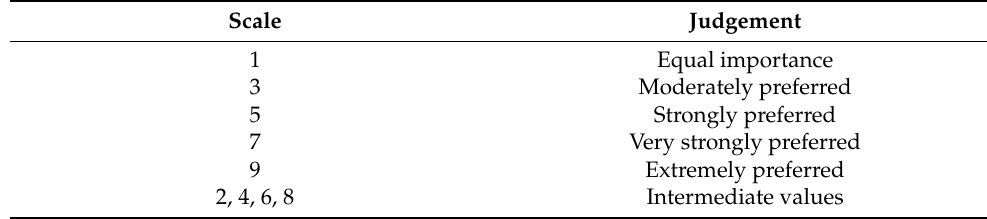
Table 1. Scale of relative preference for pairwise comparison. Source: [31].